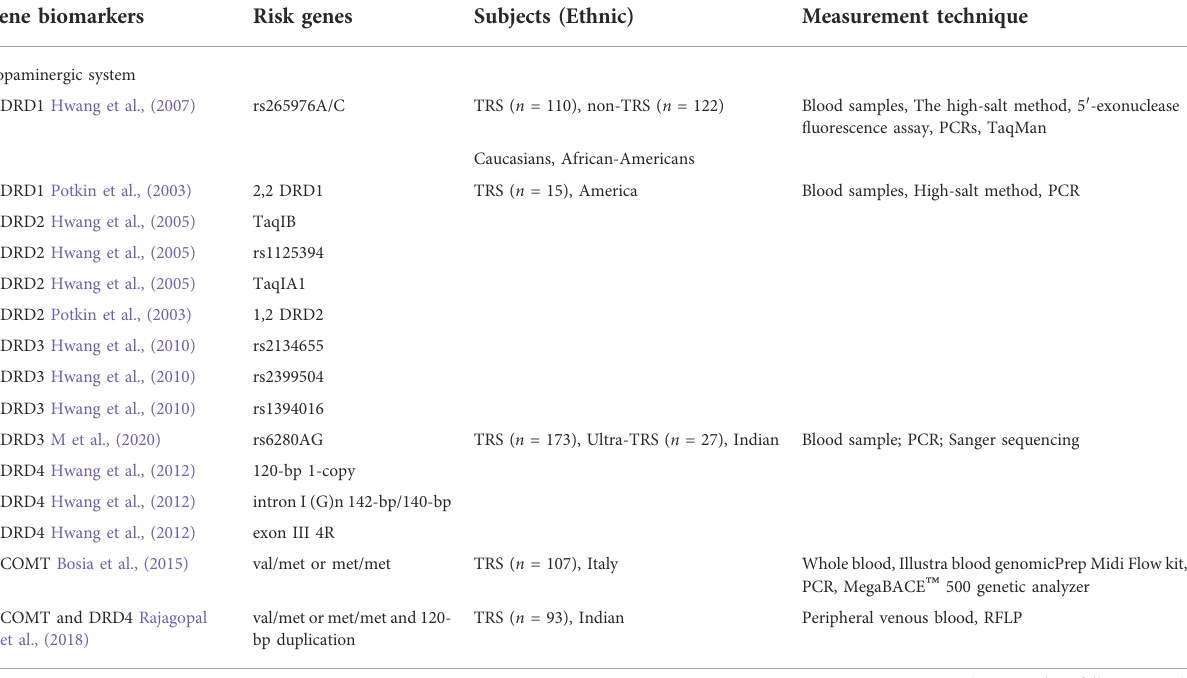
TABLE 3 Genetic biomarkers of treatment resistant schizophrenia with clozapine